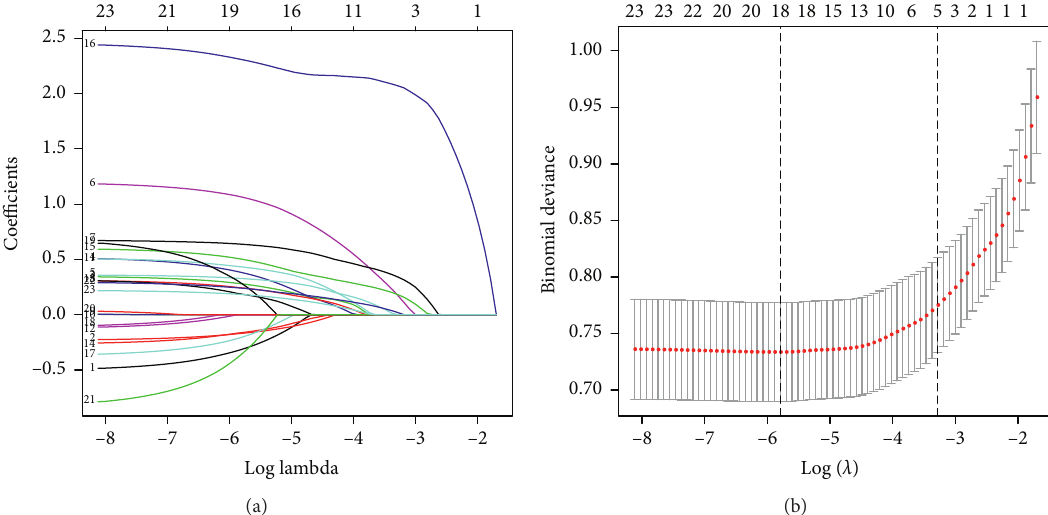
Figure 1: Clinical feature selection using the LASSO binary logistic regression model. (a) A coefficient profile plot was drawn against the log (lambda) sequence. (b) Eighteen features with nonzero coefficients were screened by optimal lambda. The partial likelihood deviance (binomial deviance) curve was drawn versus log (lambda). Dotted vertical lines were plotted according to 1 standard error